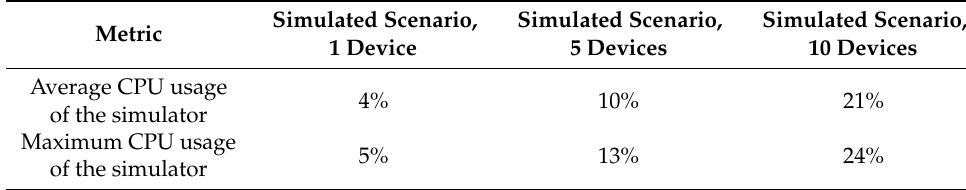
Table 7. Values of scalability metrics related to computer resource